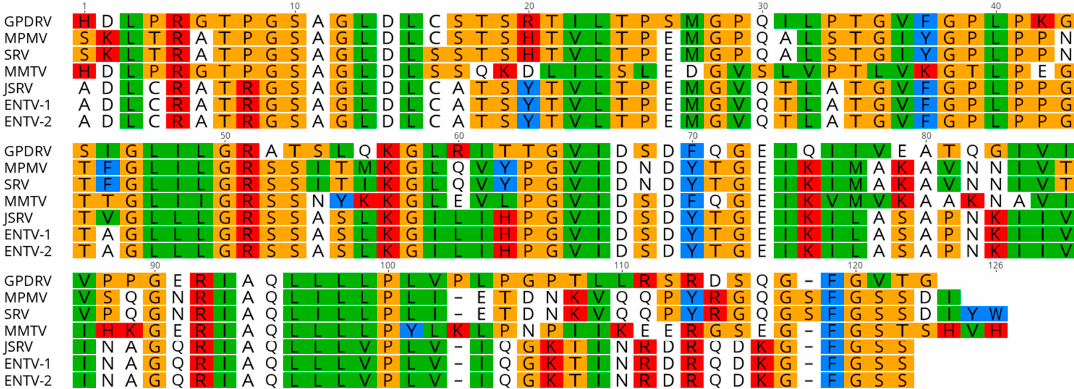
Figure 3. Amino acid alignment of the dUTPase domain from several betaretroviruses. Amino acid alignment was constructed using sequences GPDRV- Gunnison’s prairie dog retrovirus (this manuscript), MPMV- Mason-Pfizer monkey virus (NC_001550), SRV (M11841), MMTV